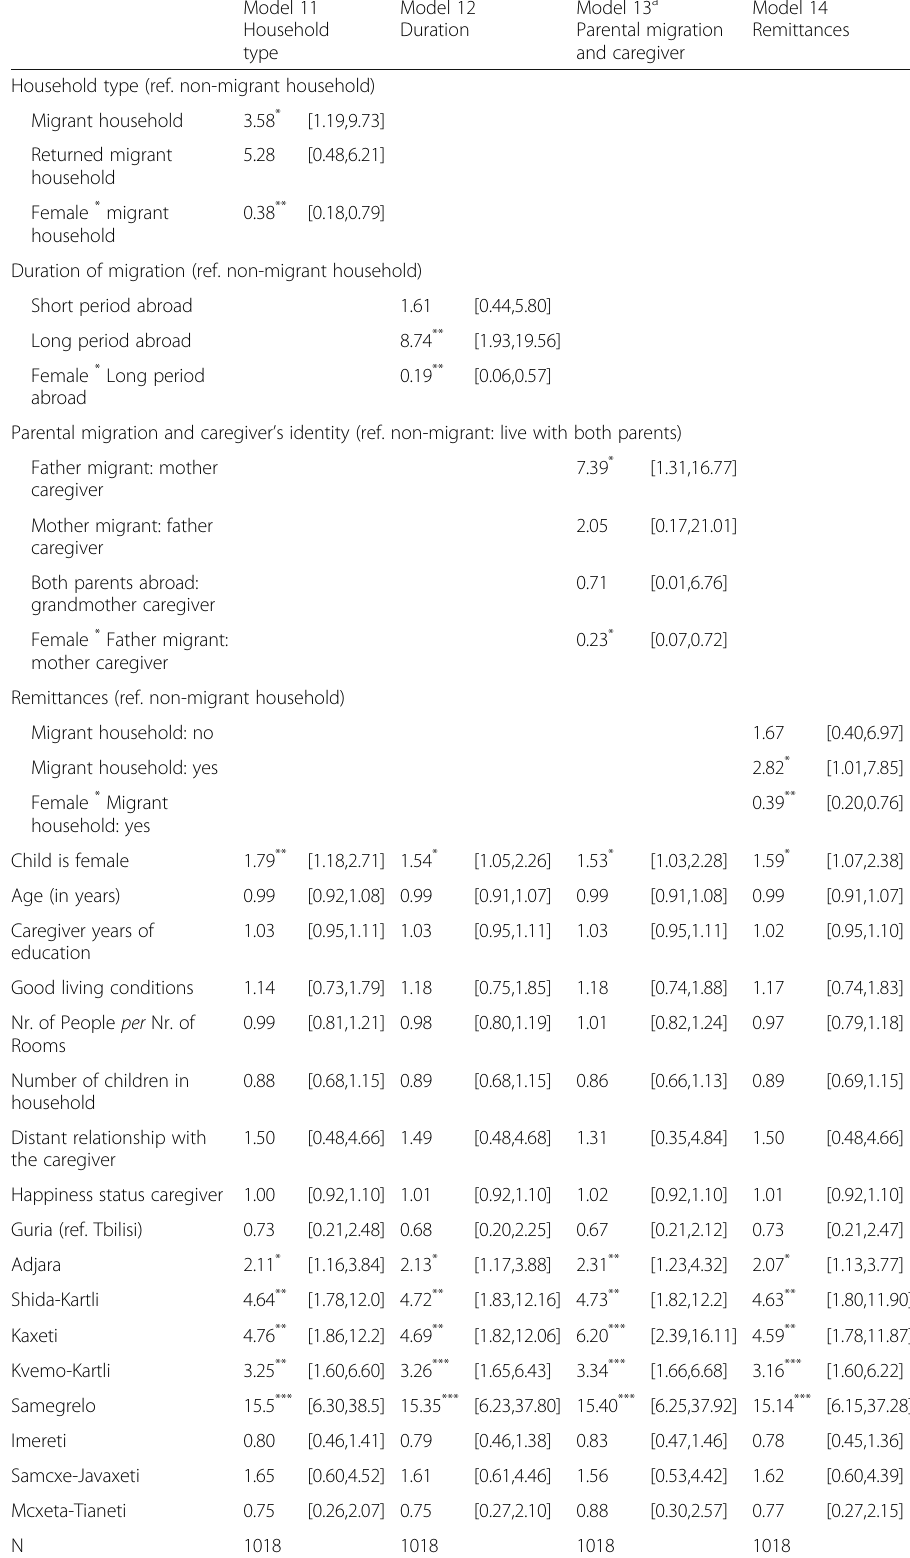
Table 4 Different transnational family characteristics and children ’ s health: